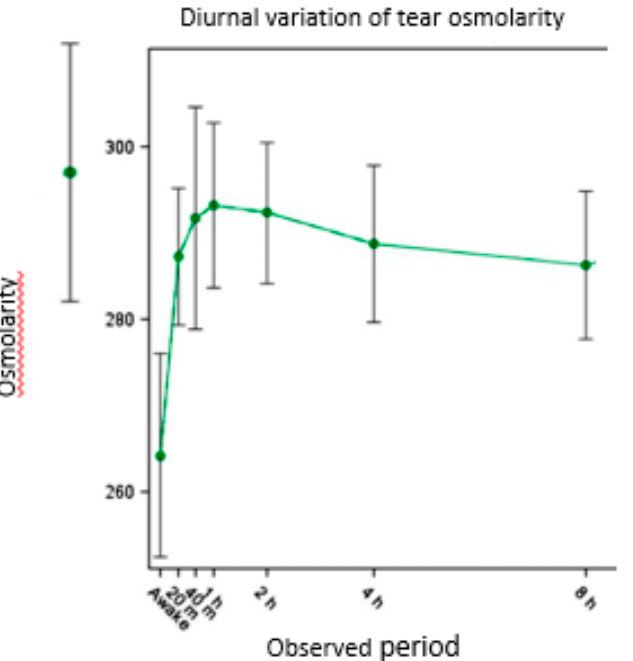
Figure 2. Diurnal tOsm over a 14-h period. A baseline tOsm measurement was made before a period of sleep. Tear osmolarity was then measured on waking and for 8 h after that time. (Adapted with permission from ref. [69]. Copyright 2013 Wolters Kluwer Health, Inc.)